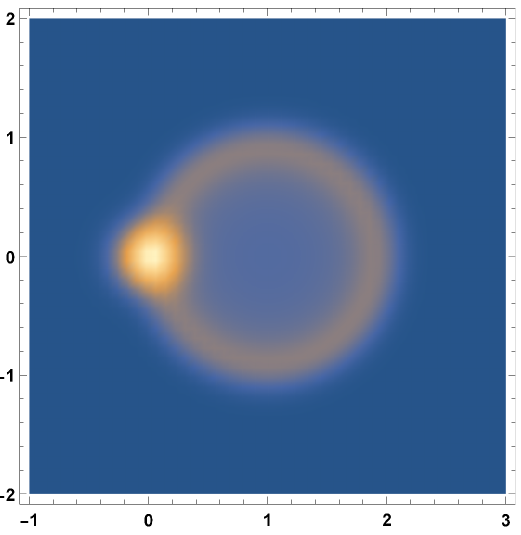
(cid:82) Γ ( p x , p y , p z − ¯ hk 0 ) dp y , vs p x and p z in units of ¯ hk 0 , for k 0 σ = Figure 3. D y ( p x , p z ) =